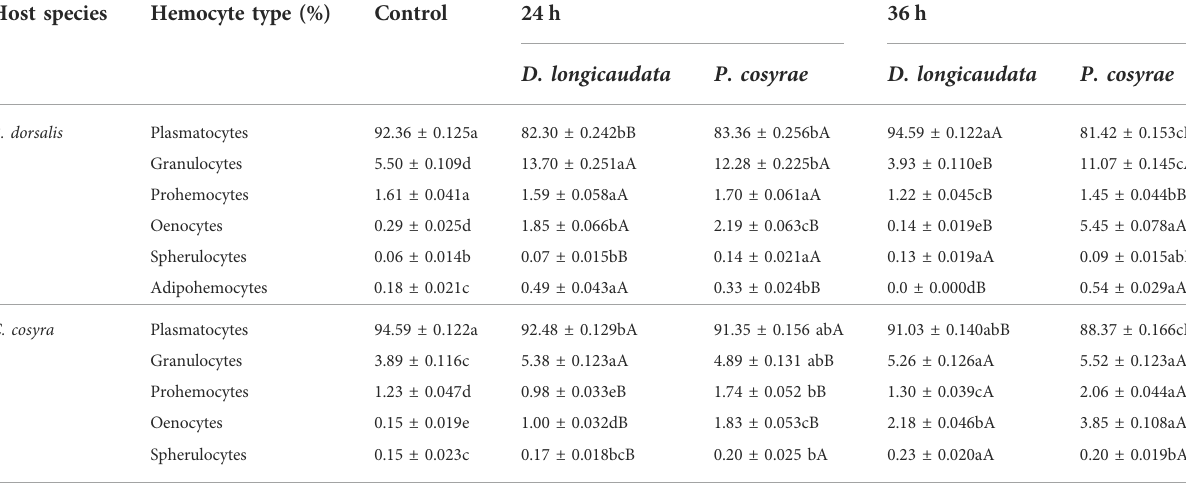
TABLE 1 Percentage of the different hemocyte types of C. cosyra and B. dorsalis before and after exposure to D. longicaudata and P. cosyrae . Percentages are based on random counts of 500 cells. Host species Hemocyte type